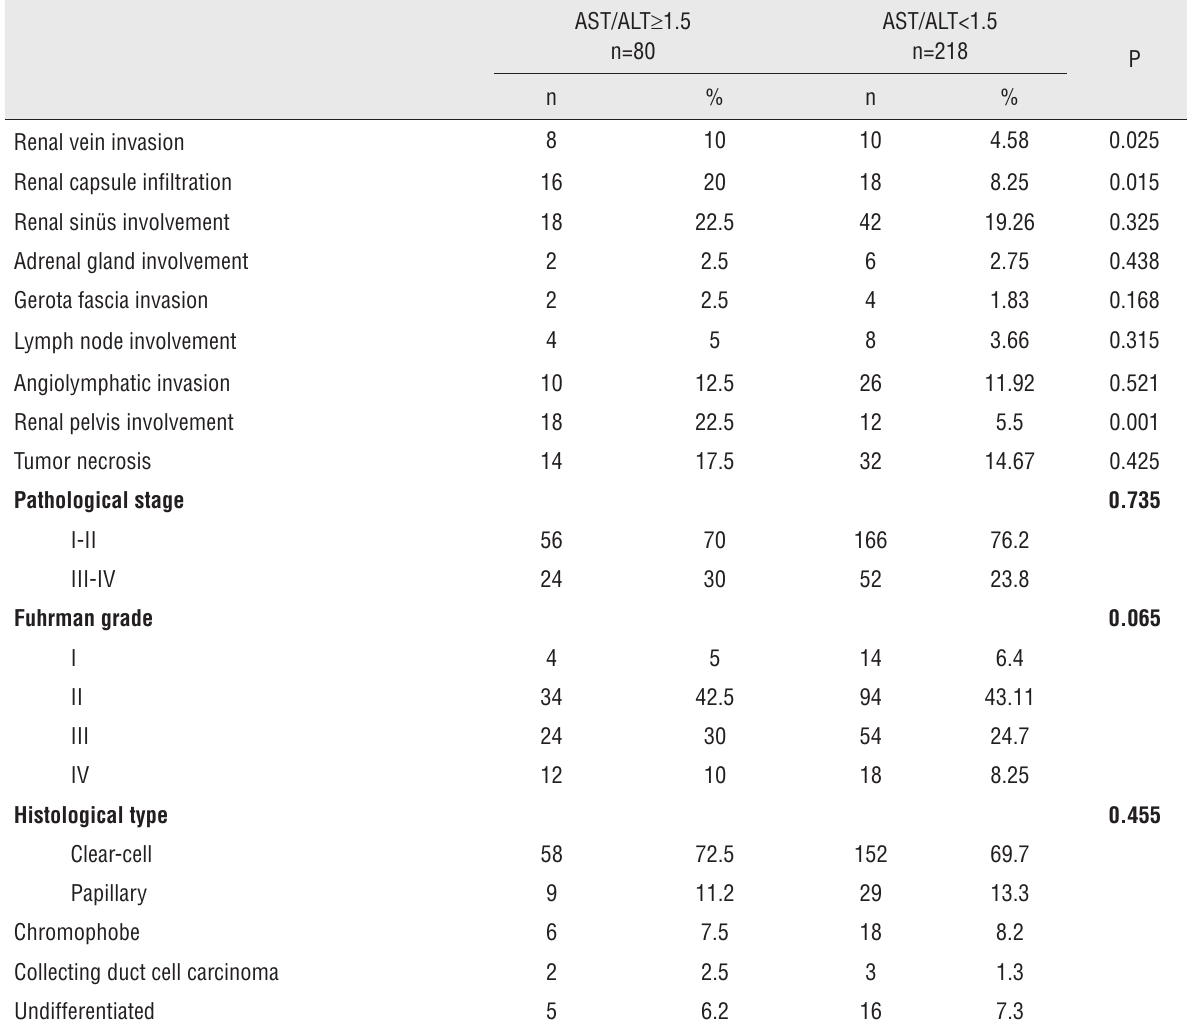
Table 4 - Association of AST/ALT ratio with pathological